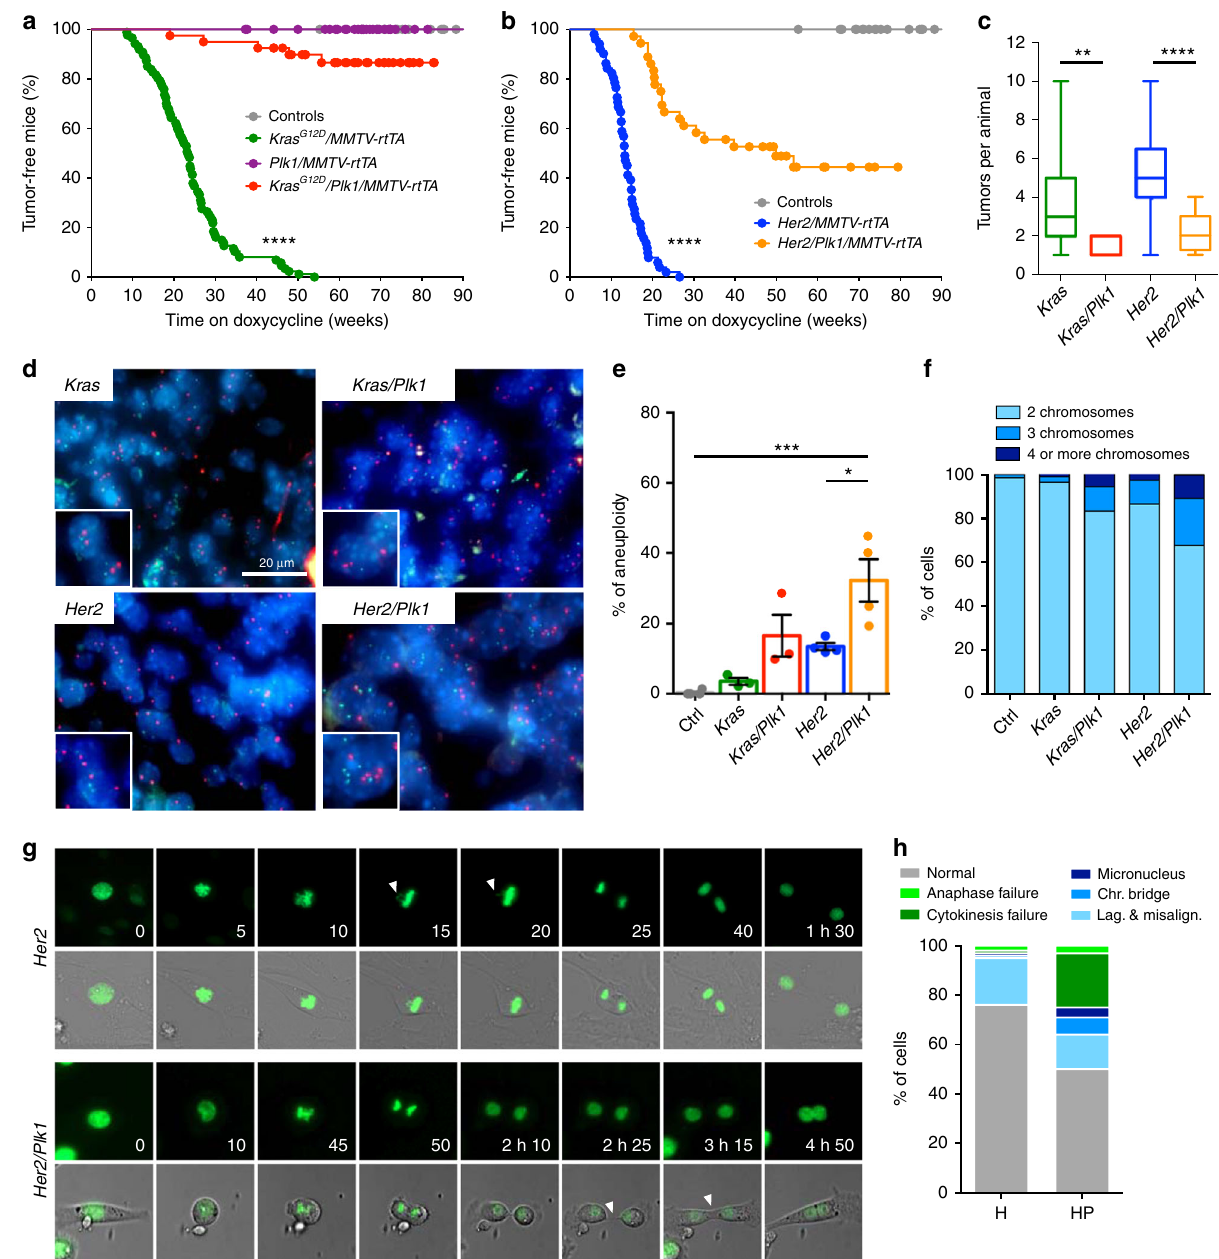
Fig. 6 Plk1 overexpression reduces tumor development induced by Kras or Her2 oncogenes. a Percentage of tumor-free mice after doxycycline administration (control, n = 33; Plk1/MMTV-rtTA n = 35; Kras G12D n = 87; Kras G12D /Plk1 n = 40 mice). b Percentage of tumor-free survival after doxycycline administration (control, n = 33; Her2 , n = 51; Her2/Plk1 , n = 36 mice). In a , b , **** p < 0.0001, Mantel – Cox test. c Number of tumors per animal in the indicated genotypes; ** p < 0.01; **** p < 0.0001; Mann – Whitney test. d Interphase-Fluorescent in situ hybridization (I-FISH) on paraf fi n sections of mammary tumors using two centromeric probes against chromosomes 16 and 17. e Quanti fi cation of the frequency of aneuploidy (left) in samples from the indicated genotypes (control, n = 4; Kras , n = 4; Kras/Plk1 , n = 3; Her2 , n = 4; Her2/Plk1 , n = 4 mice). * p < 0.05; *** p < 0.001; one-way ANOVA. f Percentage of cells with 2, 3, or 4 or more chromosomes in the indicated genotypes. g Representative micrographs of Her2 and Her2/Plk1 tumor cells in vitro (H2B-GFP green). Top: mitotic cell with a lagging chromosome. Bottom: cytokinesis failure resulting in binucleation. h Percentage of cells in Her2 tumors (H) and Her2/Plk1 (HP) with the indicated mitotic errors those with higher PLK1 expression (remaining quartiles). In keeping with the observed tumor suppressor properties of PLK1 , patients with low PLK1 expression were associated with signi fi cantly shorter overall survival, compared to those with higher PLK1 expression levels (Fig. 8c, p = 0.0099; hazard ratio (HR), 0.59; 95% con fi dence interval (CI), 0.40 – 0.89). These results remained signi fi cant in multivariate analysis, including NATURE COMMUNICATIONS| (2018) 9:3012 |DOI: